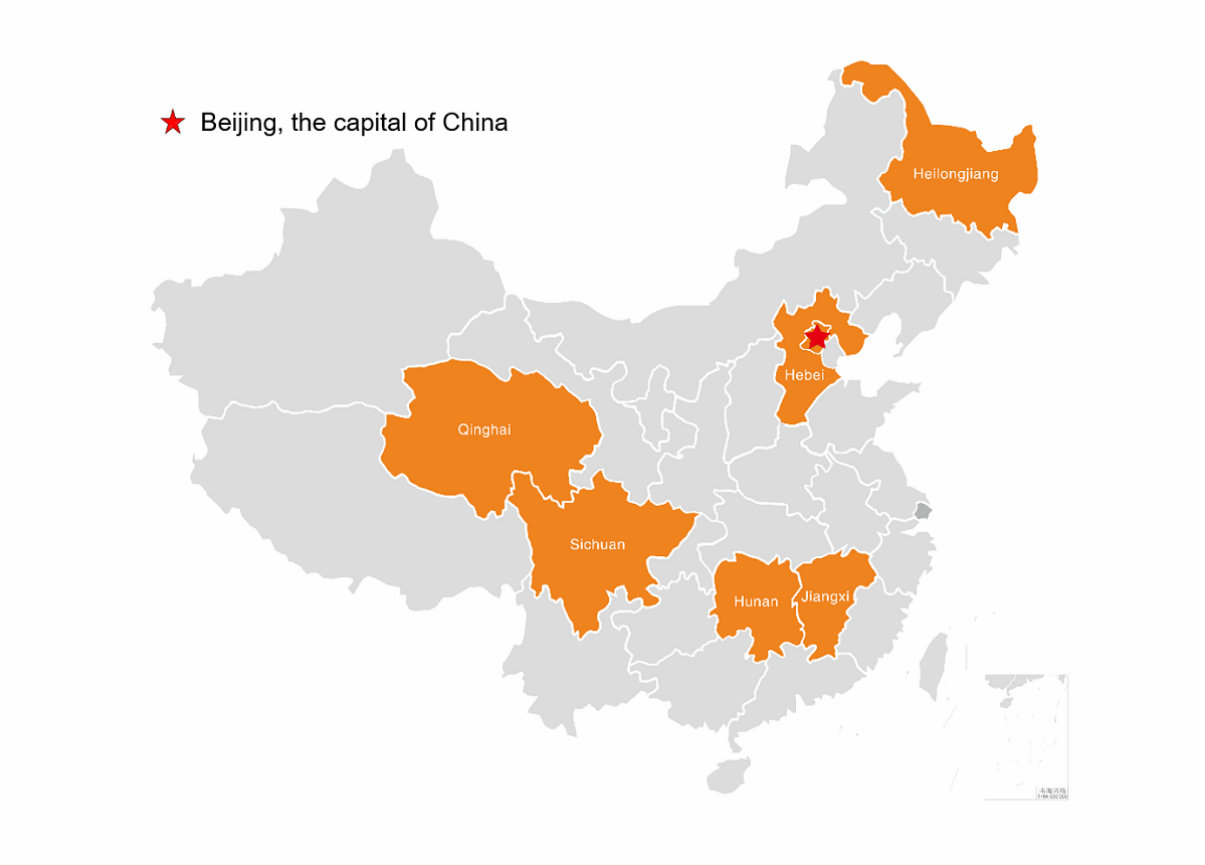
Figure 2. The study sites of the Action on Salt China (ASC) cluster of randomized controlled